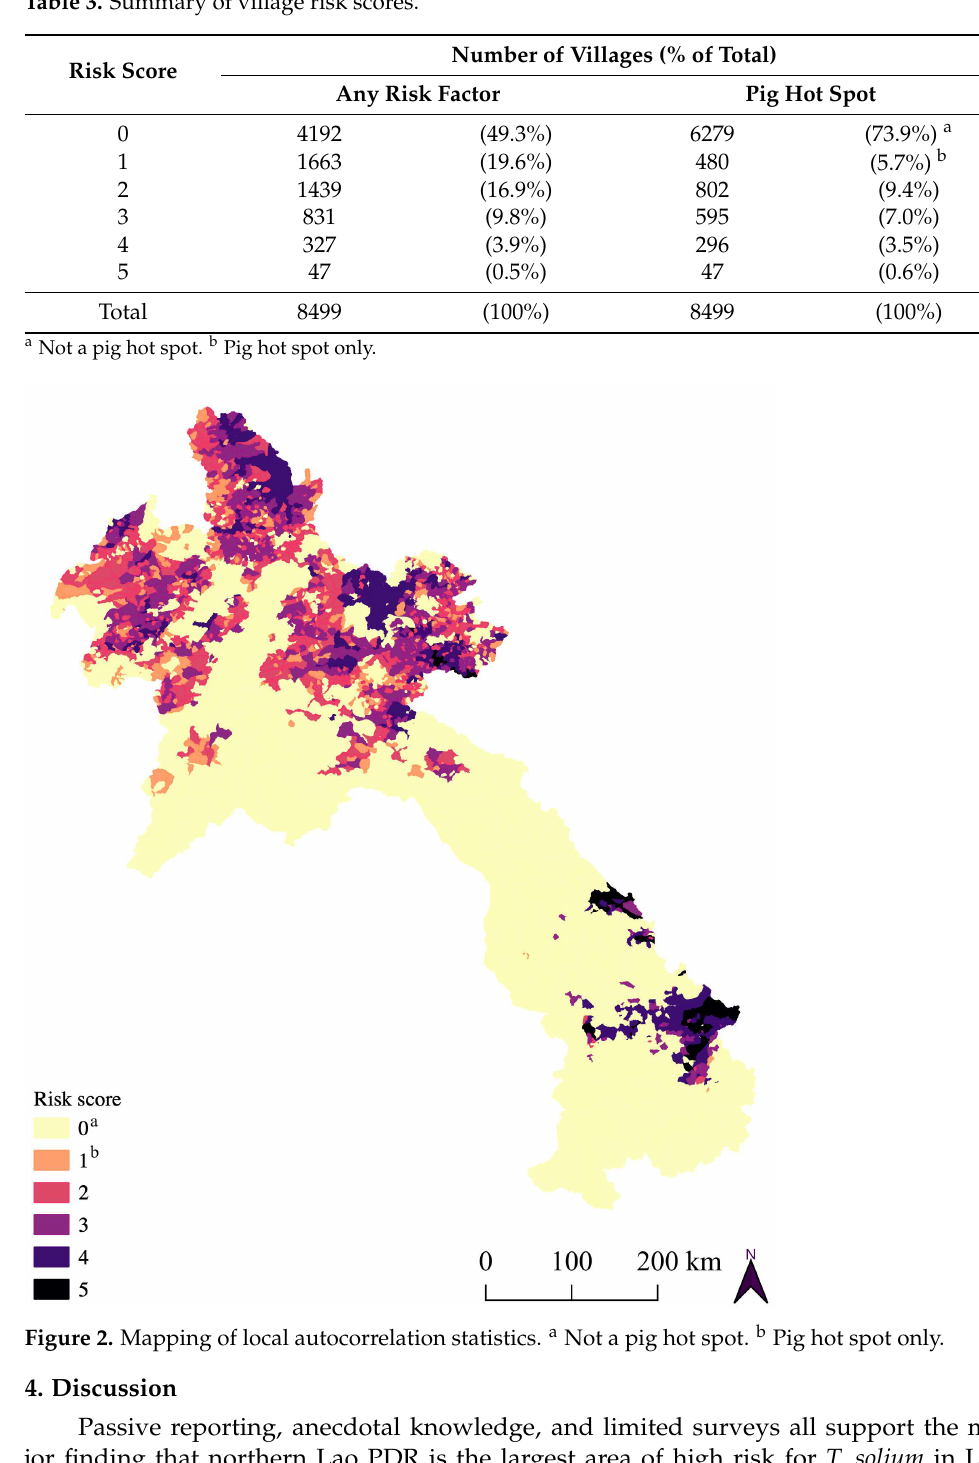
Table 3. Summary of village risk scores.